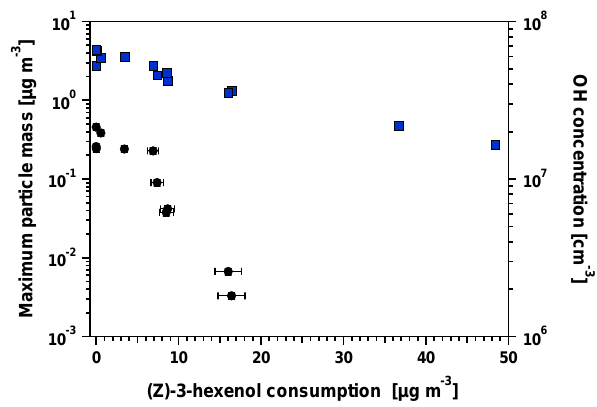
Fig. 8. Maximum particle mass (black circles, left scale) and OH concentrations (blue squares, right scale) upon addition of up to 48µgm − 3 of ( Z ) -3-hexenol to the reaction chamber filled with 43 ± 4µgm − 3 α -pinene. Above 17µgm − 3 ( ∼ 6ppb) of ( Z) -3- hexenol, no particle formation from α -pinene oxidation was ob- served. Note logarithmic scales on both y